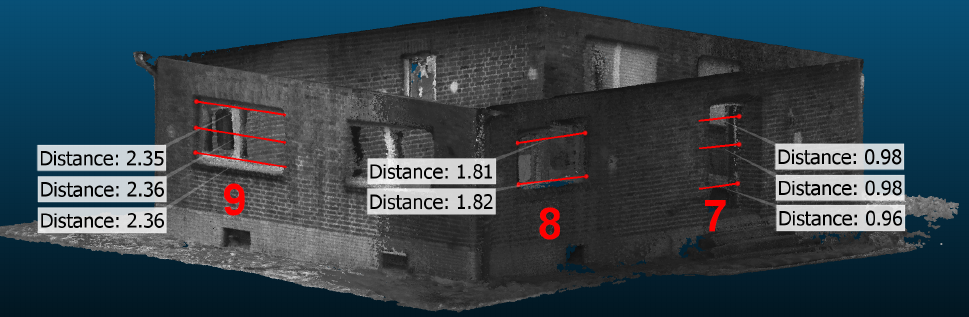
Figure 14. Subset of the IPS point cloud with three examples of distance measurements (m), see second column of Table 3—Ids 7, 8, and 9.